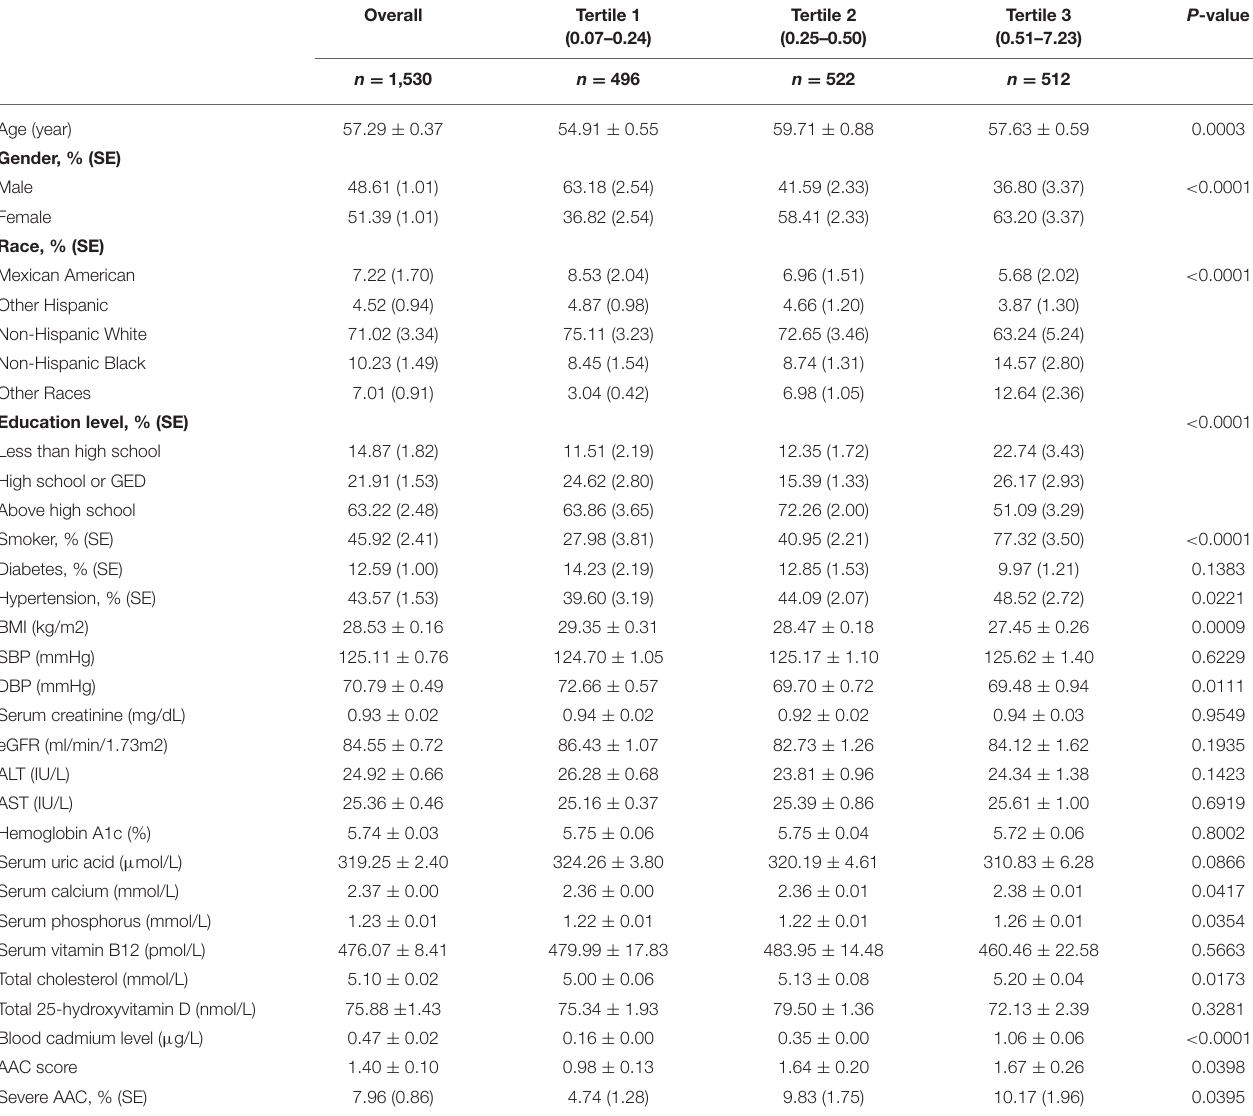
TABLE 1 | Weighted baseline characteristics of participants according to blood cadmium